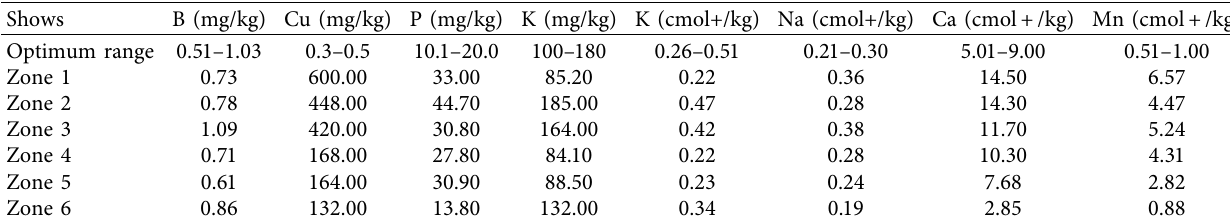
Table 3: Values of fertility analysis from soil samples collected from Los Maitenes wetland. Shows Optimum range 0.51–1.03